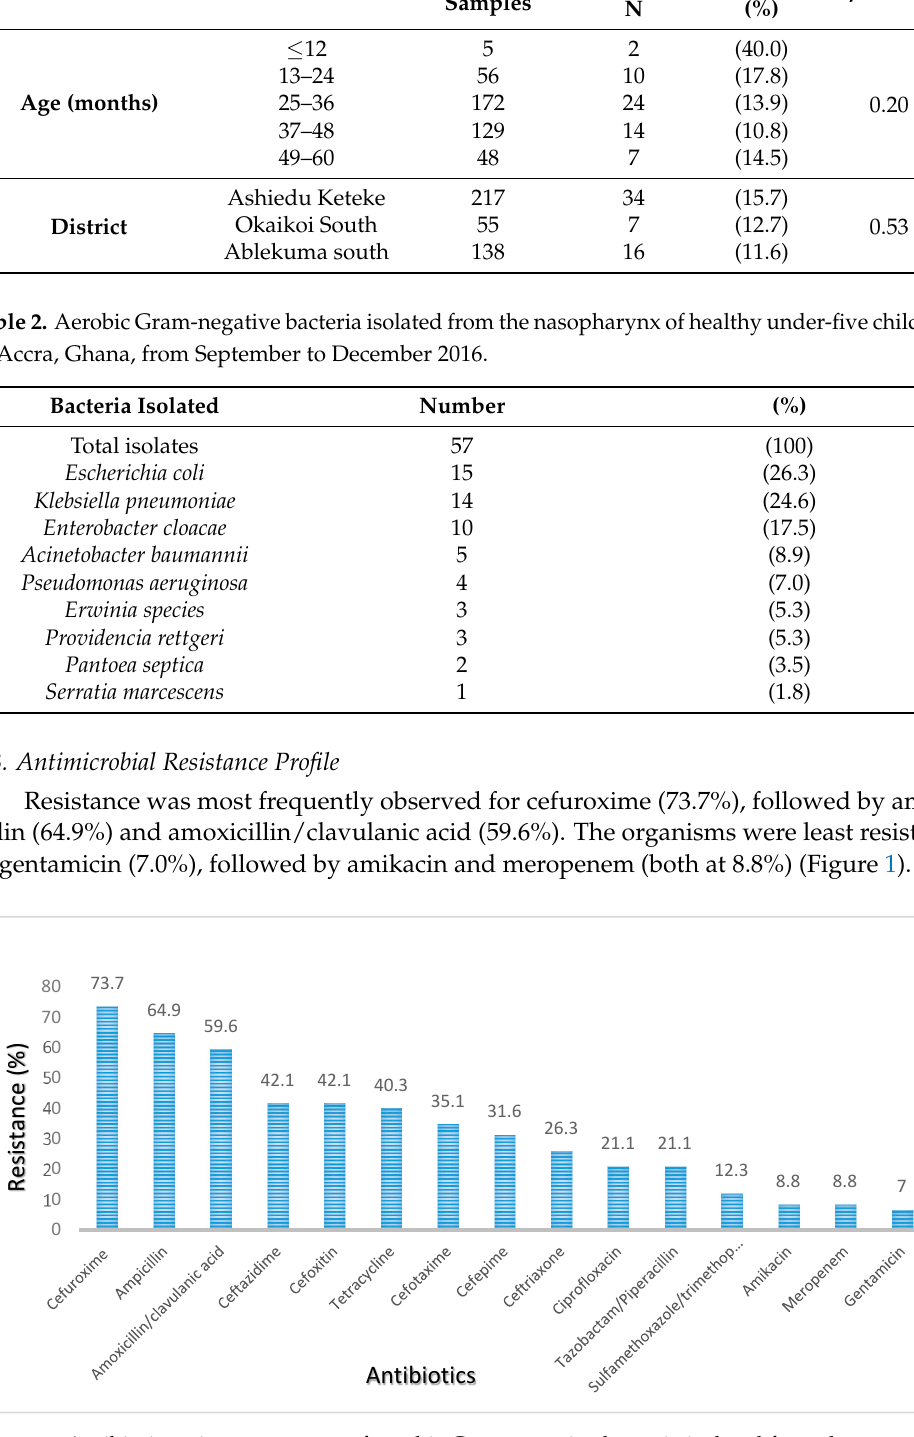
Figure 1. Antibiotic resistance pattern of aerobic Gram-negative bacteria isolated from the nasophar- ynx of healthy under-five children in Accra, Ghana, from September to December